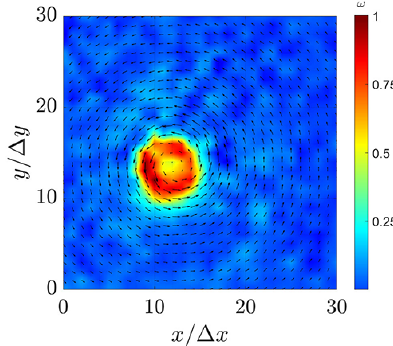
Figure 17. Instantaneous vorticity magnitude with the central dif- ferentiation scheme and quiver lines of the velocity